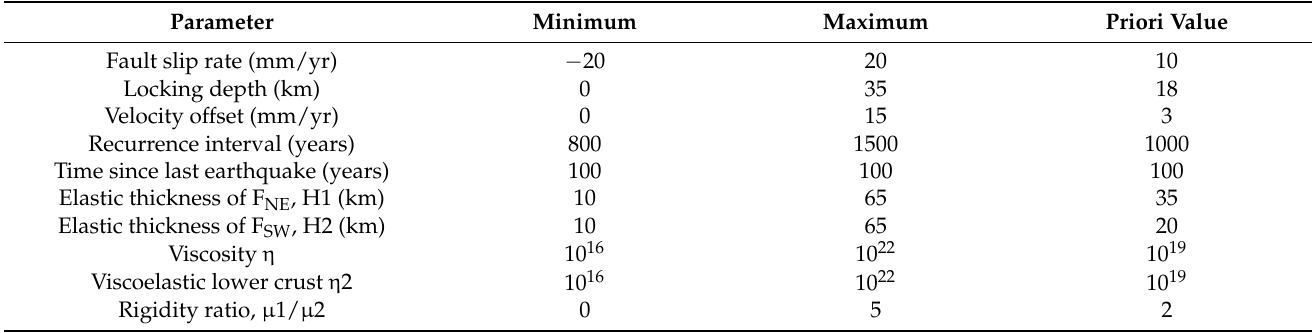
Figure A3. Maximum a posteriori probability (MAP) solution for profiles MN ( a ) and PQ ( b ). With the model, it has the same elastic thickness on both sides of the fault.